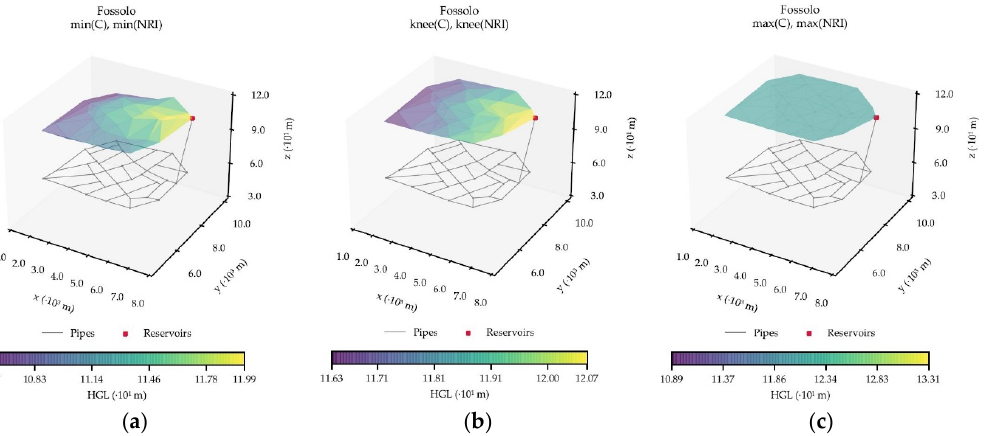
Figure 4. Fossolo WDSs with the corresponding HGL surfaces for the: ( a ) [min( C ), min( NRI )]; ( b ) [knee( C ), knee( NRI )]; and ( c ) [max( C ), max( NRI )] configurations.